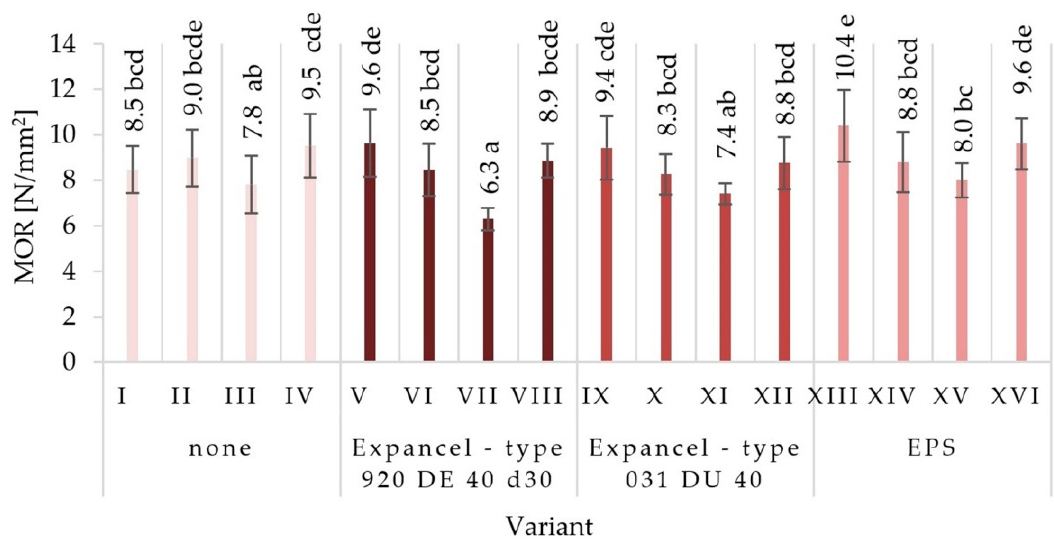
Figure 3. Static bending strength (MOR) of the particleboards produced (means and standard deviation, a, b, c, (…). Homogeneous groups were determined by the Tukey test; different letters denote a significant difference; means followed by the same letter do not statistically differ from each other).